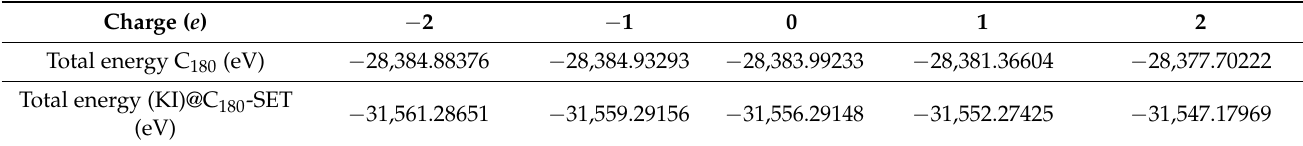
Figure 2. The dependency of the total energy of molecules C 180 -SET and (KI)@C 180 -SET on their total charge. Table 1. Dependence of the total energy of fullerene molecules on the charge state.